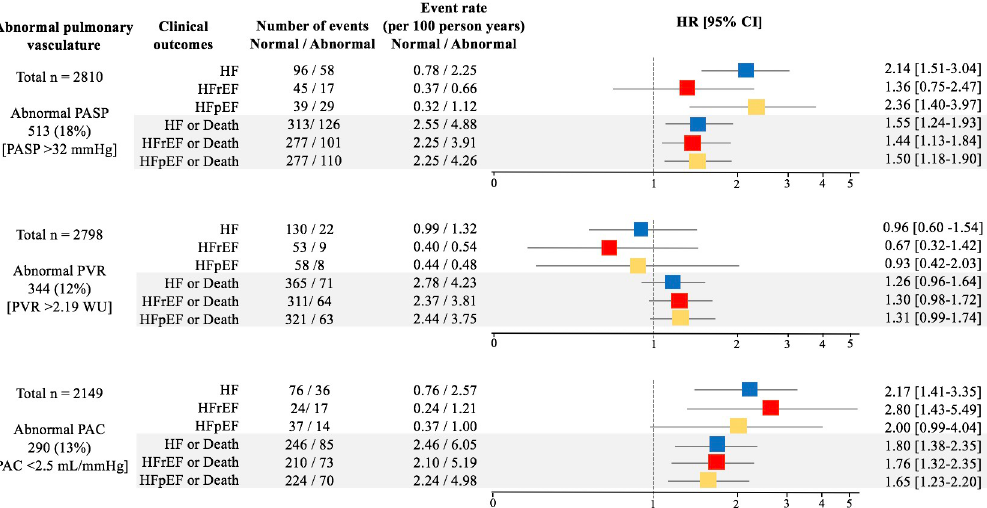
Fig 4. Association of abnormalities of pulmonary vascular measures (PASP, PVR, PAC) with incident HF overall, incident HFpEF, incident HFrEF, or the composite of death with each of these. Models are adjusted for age, sex, race, visit center, BMI, hypertension, diabetes, LVEF, LAVi, LVMi, and septal E/e’. BMI, body mass index; HF, heart failure; HFpEF, HF with preserved LVEF; HFrEF, HF with reduced LVEF; HR, hazard ratio; LAVi, left atrial volume index; LV, left ventricular; LVEF, LV ejection fraction; LVMi, LV mass index; PAC, pulmonary arterial compliance; PASP, pulmonary artery systolic pressure; PVR, pulmonary vascular resistance; WU, Wood unit.